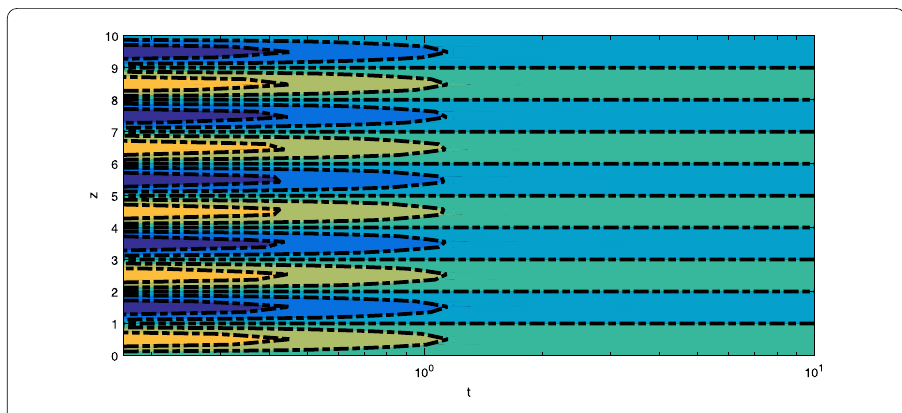
Figure 6 The contour plot of solution curves given by (47) of fractional heat equation (1) for different values of α = 0.4,0.6,0.8,1.0 and at fixed values x = y = 0.5 in the tz